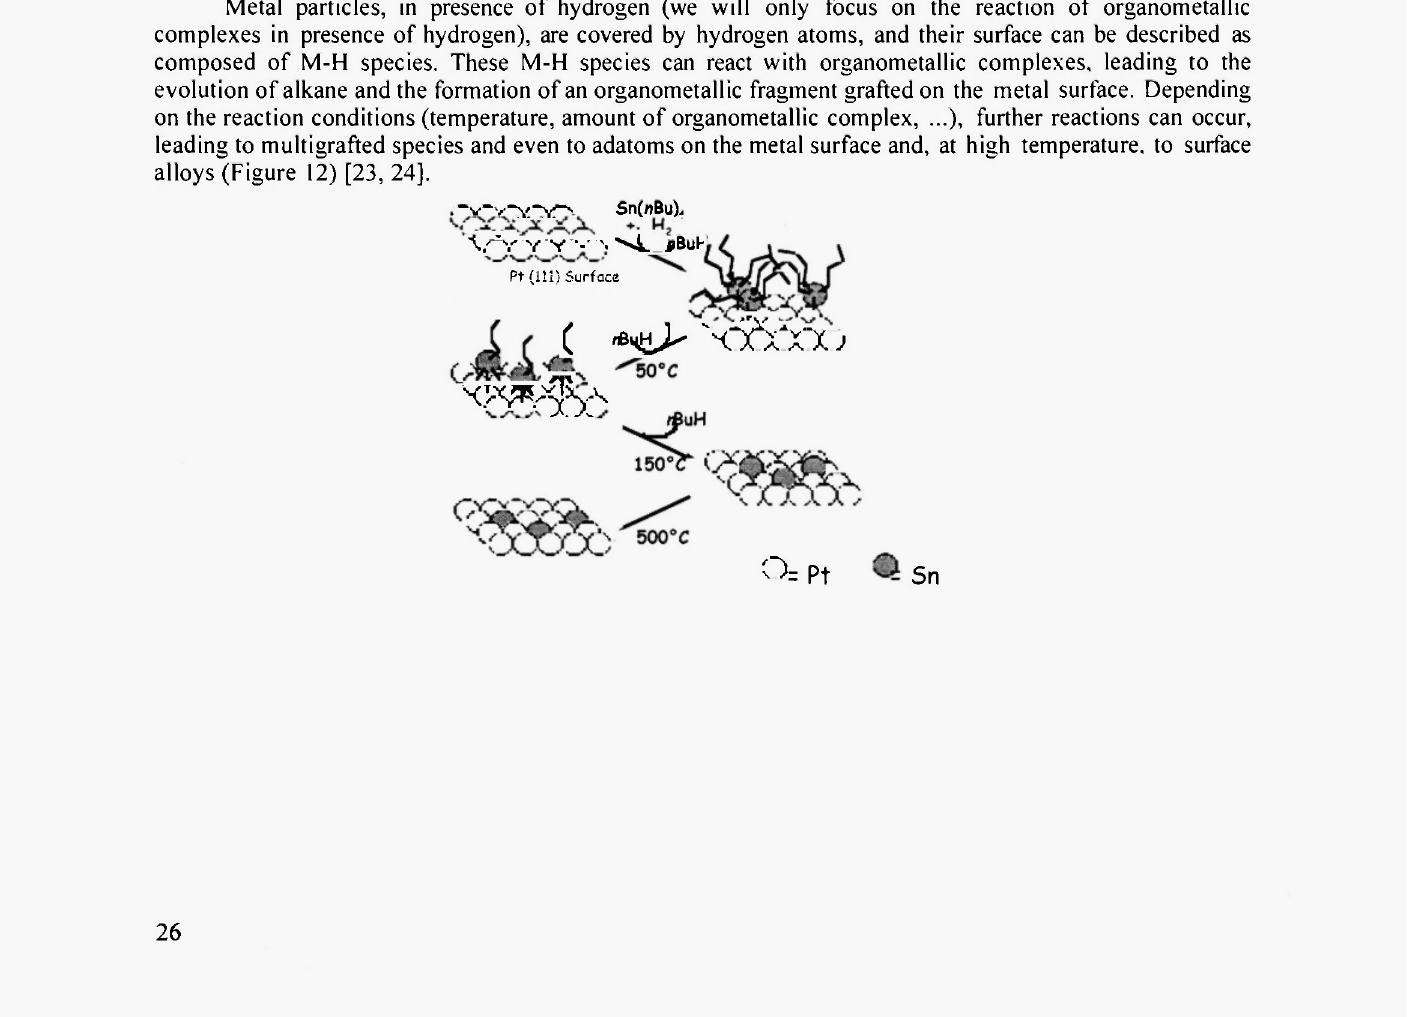
Figure 11 : Adsorption isotherms of various hydrocarbons on MCM-41 and on MCM-41 modified by reaction with tin alkyl complexes. SURFACE ORGANOMETALLIC CHEMISTRY OF TIN AND ARSENIC ON